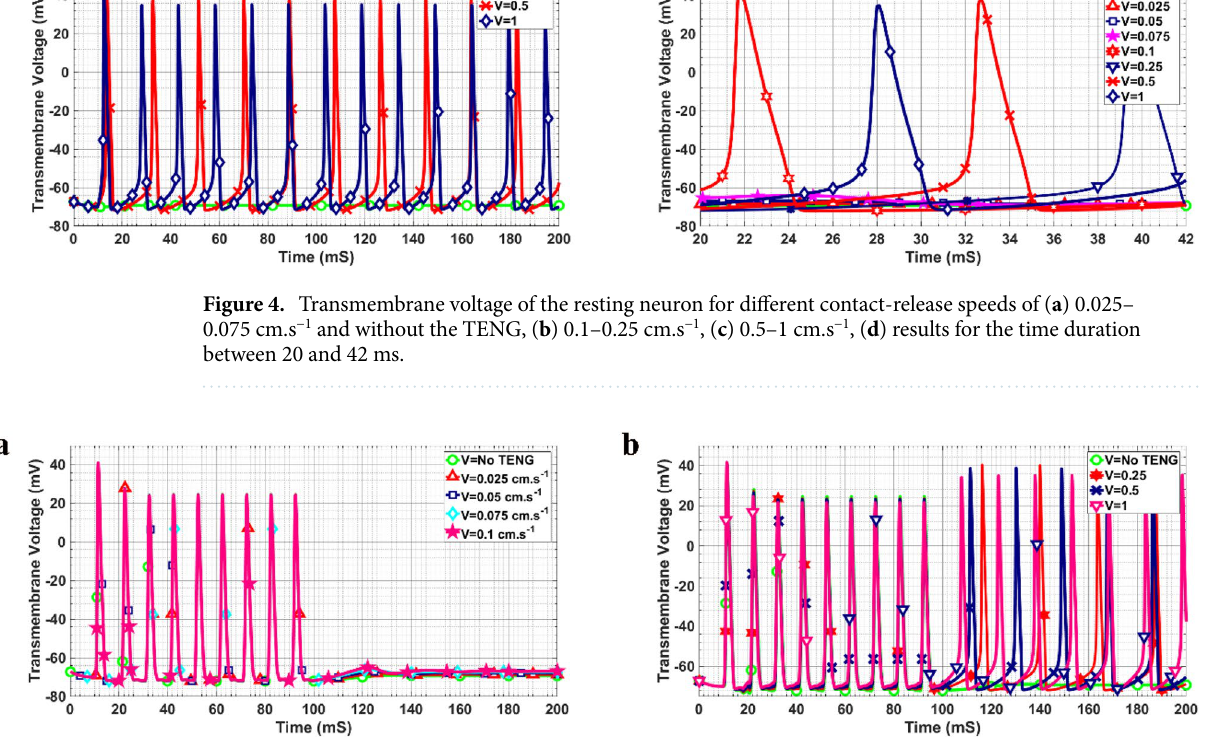
Figure 5. Transmembrane voltage of the firing neuron for different contact-release speeds of ( a ) 0.025–0.1 cm. s −1 and without TENG, ( b ) 0.25–1 cm.s −1 .